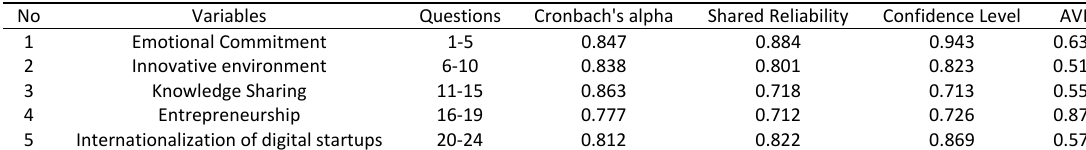
Table1. Variables, the Number of Questions and Reliability